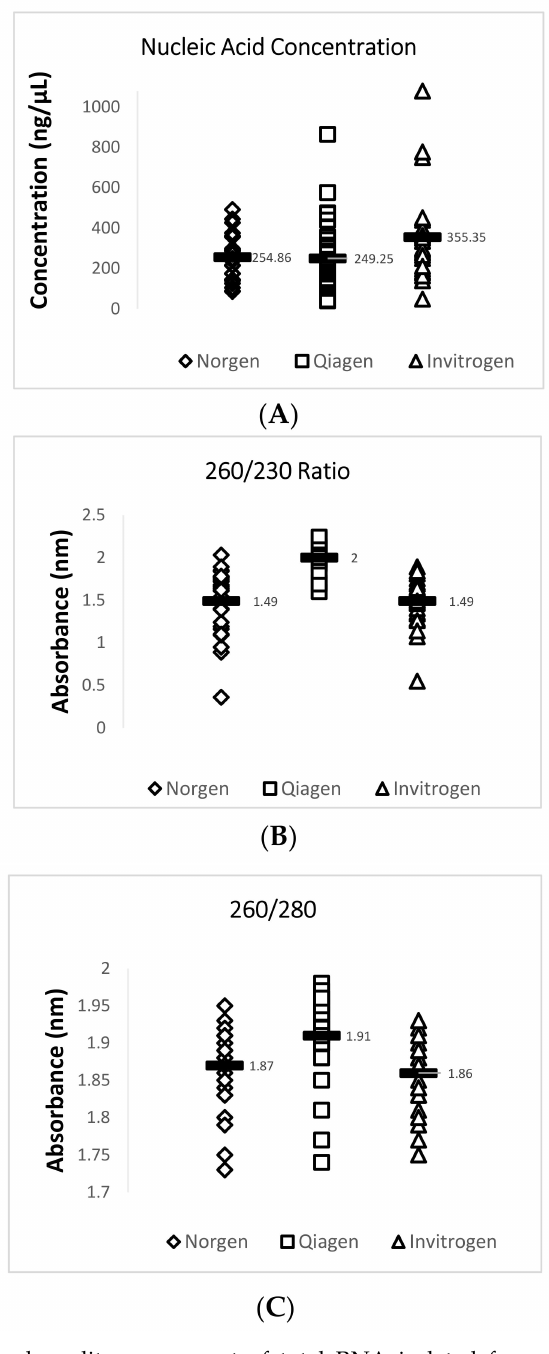
Figure 2. Quantity and quality assessment of total RNA isolated from archived TSV-infected Davidson’s-fixed para ffi n-embedded (DFPE) shrimp tissues. Each test was run in triplicate and a mean value for each data set was obtained. The figure in ( A ) shows a comparison of the mean nucleic acid concentrations for 29 samples from each extraction kit. The figure in ( B ) shows a comparison of the mean 260 / 230 ratio values for 29 samples from each extraction kit. The figure in ( C ) shows a comparison of the mean 260 / 280 ratio values for the 29 samples from each extraction kit. The horizontal line in each group represents a geometric mean of the data in the corresponding vertical data